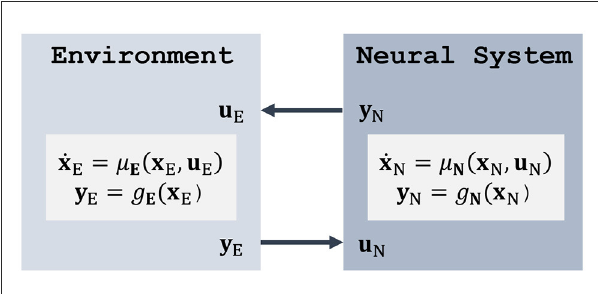
FIGURE1 Classical agent-environment loop, where a neural system interacts with its environment by observing its states and applying feedback control. Here, the deterministic case is shown for simplicity; see Equation (1) for the stochastic